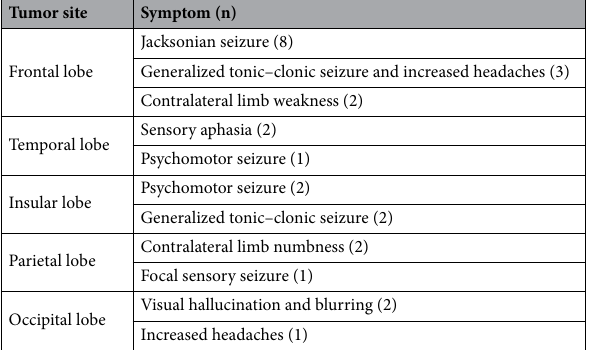
Table 1. The detailed symptoms associated with tumor sites in the symptomatic